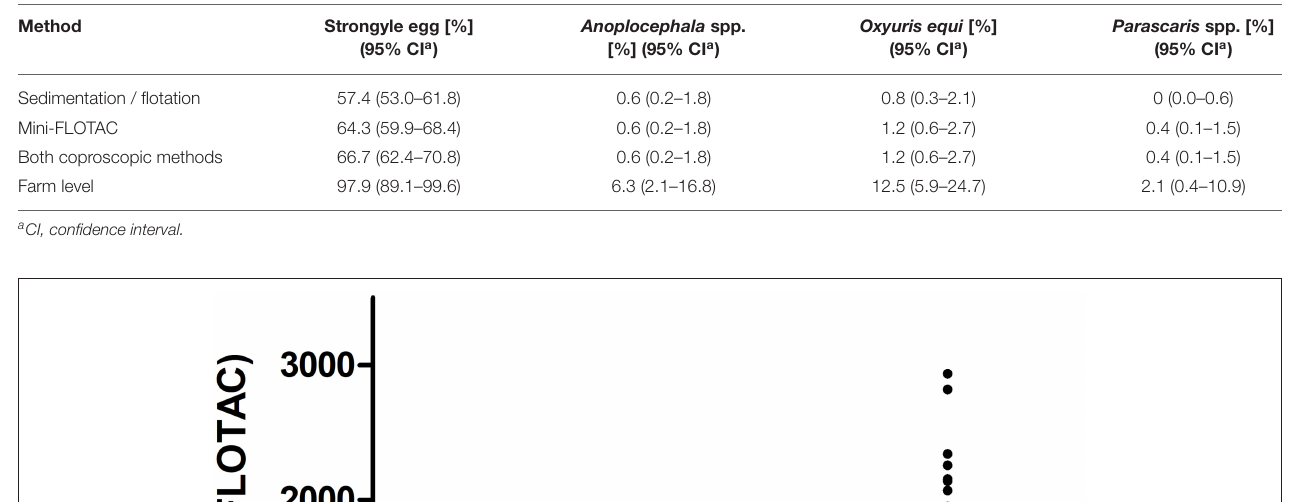
TABLE 3 | Percentage of 484 equine faecal samples tested positive using different FEC methods.